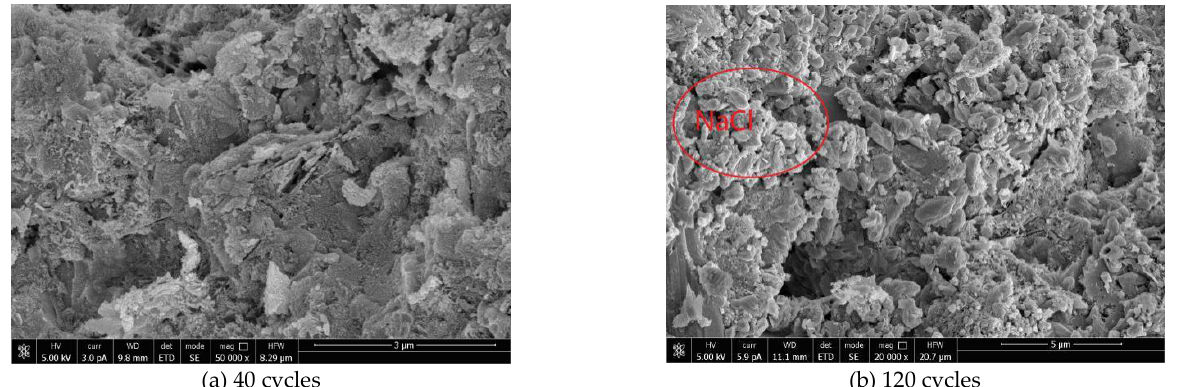
Figure 18. Microscopic morphology of MK concrete eroded by NaCl solution.